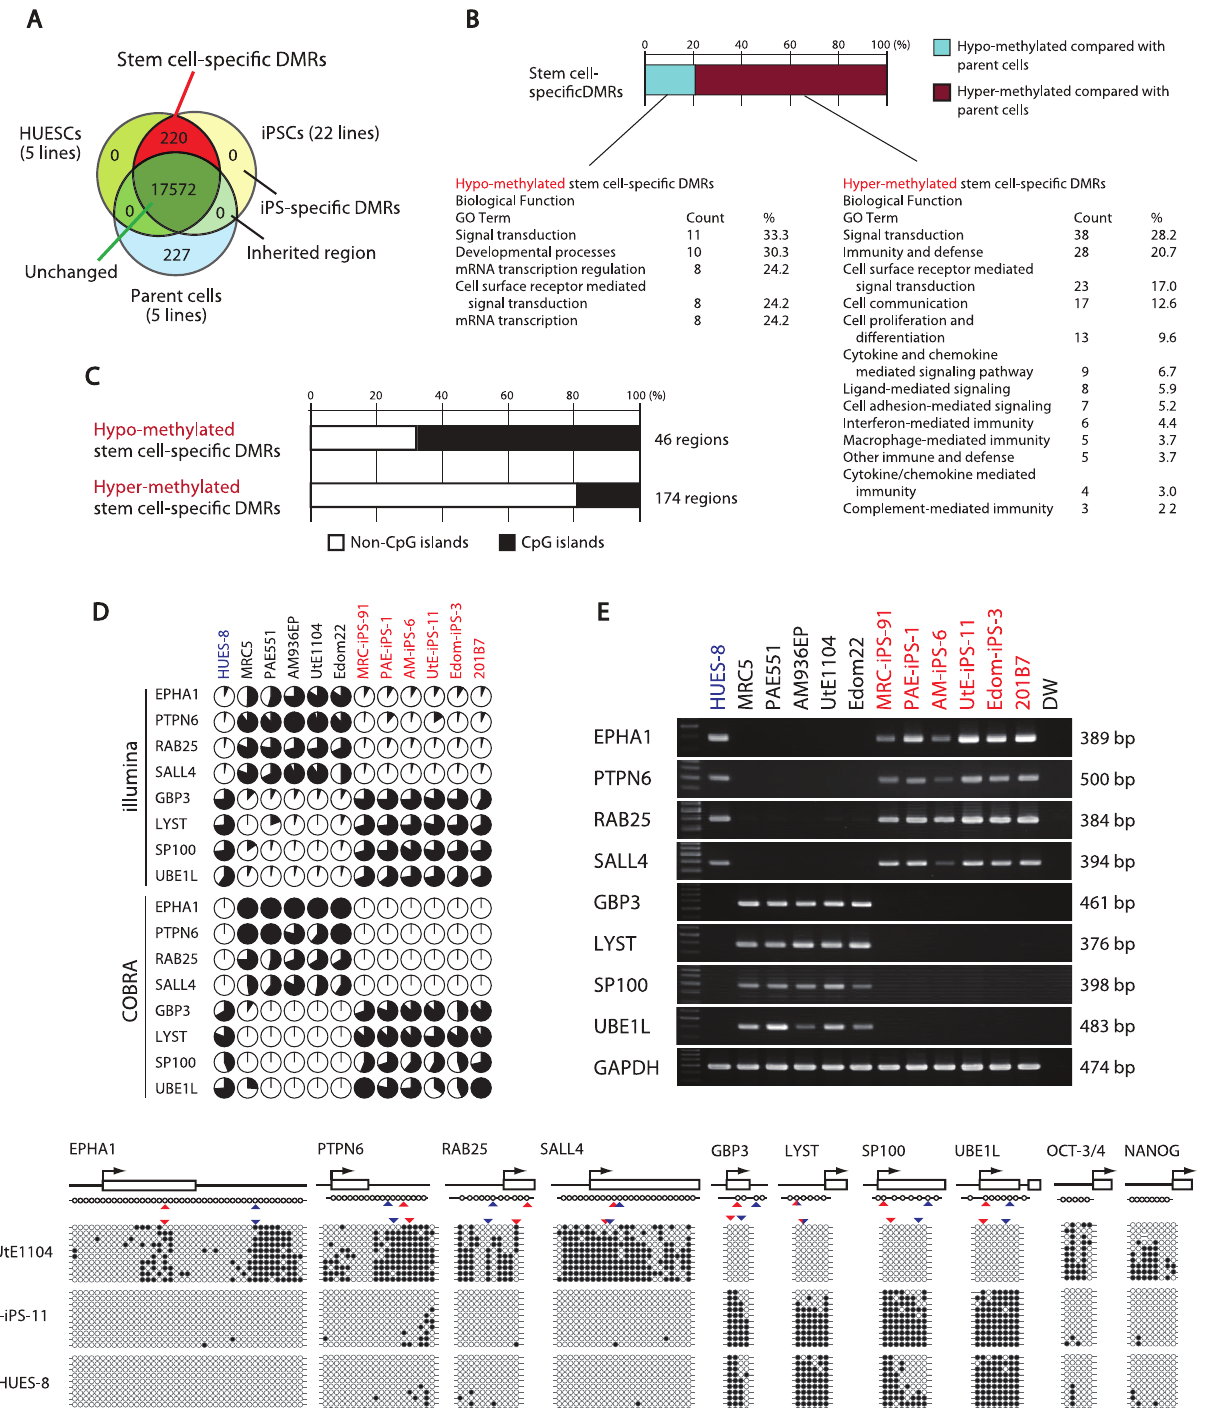
Figure 2. Defining stem cell-specific DMRs as novel epigenetic iPS markers. ( A ) Venn-like diagram showing overlapping CpG sites among ESCs, iPSCs and their parent cells. The 220 overlapping sites are stem cell-specific differentially methylated regions (DMRs). Notably, neither overlapping iPSCs-specific DMRs nor inherited regions in iPSCs from the parent cells were observed. ( B ) Proportion of the hyper- and hypo- methylated stem cell-specific DMRs and GO analysis. Approximately 80% of the regions were hyper-methylated in iPSCs, compared with that of the parent cells. ( C ) Proportion of the regions associated with CpG islands and non-CpG islands in the hypo-methylated stem cell-specific DMRs. The hypo-methylated regions were biased to CpG islands, whereas the hyper-methylated regions were biased to non-CpG islands. ( D ) DNA methylation levels in the 8 representative genes determined by Illumina Infinium HumanMethylation27 assay and Bio-COBRA. These 8 genes were defined as SS- DMRs with significant changes of expression and were described in Table S6. The relative amount of methylated and unmethylated DNA ratio is indicated as the black and white area, respectively, in the pie chart. ( E ) Expression of the 8 genes. Expression of the 8 genes had an inverse correlation with DNA methylation level. ( F ) Bisulfite sequencing analysis of the 8 genes in endometrial cells (UtE1104), UtE-iPS-11 and HUES-8 cells. (Top)